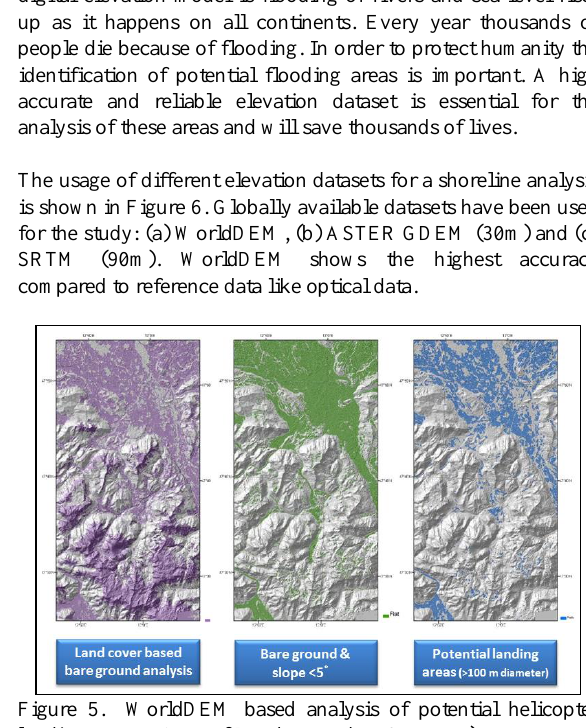
Figure 5. WorldDEM based analysis of potential helicopter landing zones - Area of Berchtesgarden,